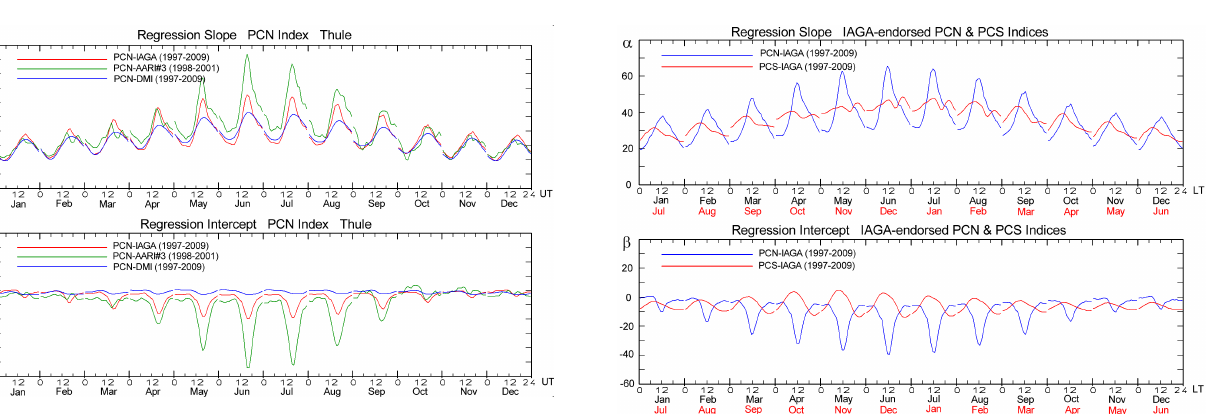
Figure 10. Slope and regression coefficients for PCN (blue) and PCS (red line) from the IAGA-endorsed PC index procedure. Data from Thule, Vostok and OMNI 1997–2009. Reverse convection cases included (Index coefficients from http://pc-index.org, 2014).